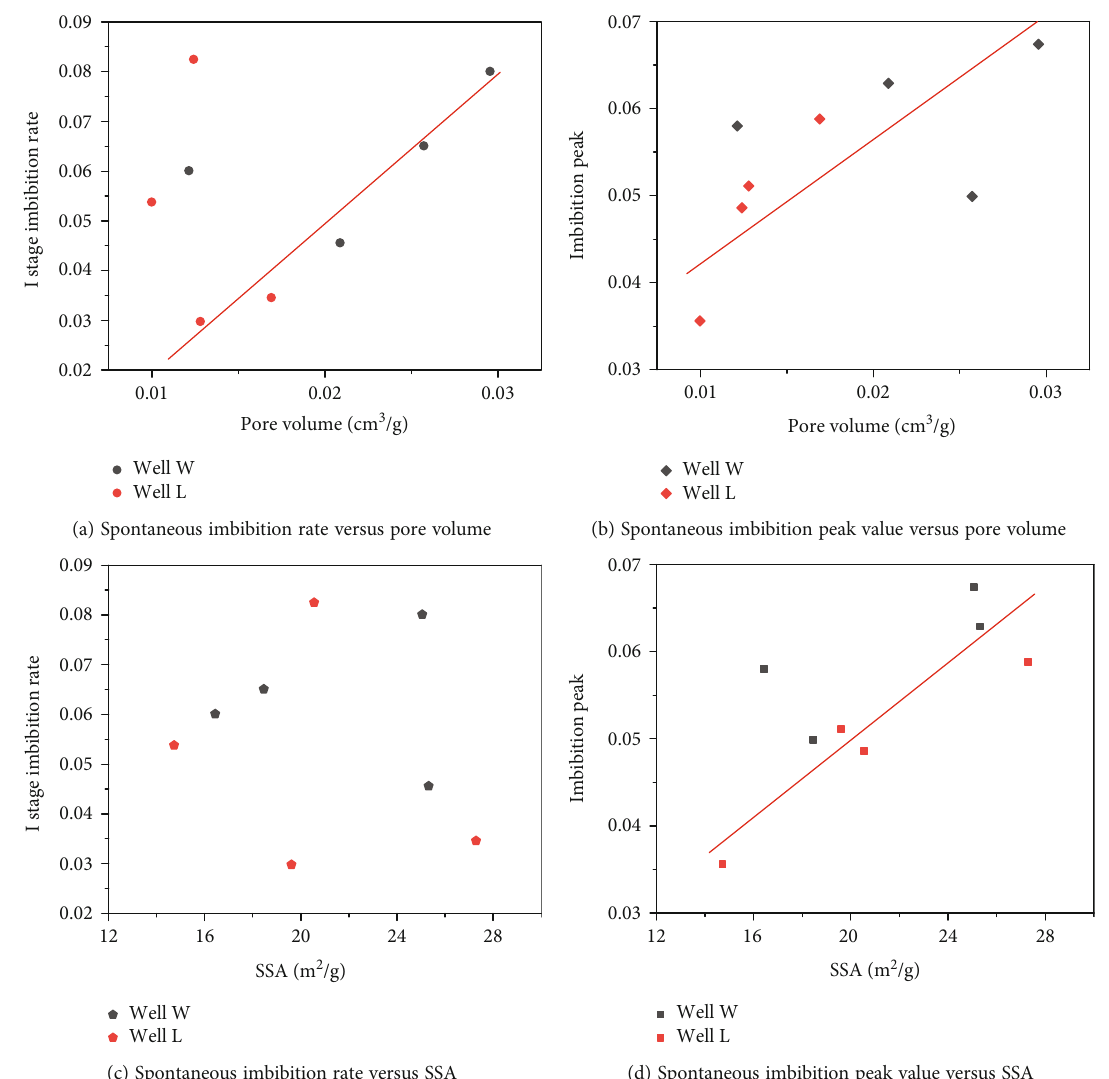
Figure 11: Relationship between spontaneous imbibition rate/imbibition capacity and pore structure of the deep